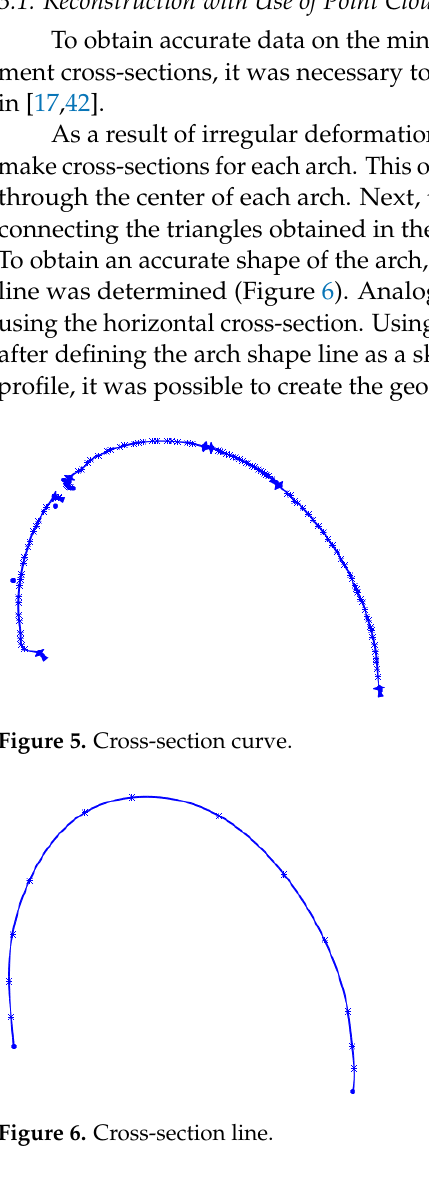
Figure 4. Measurement cross-sections.